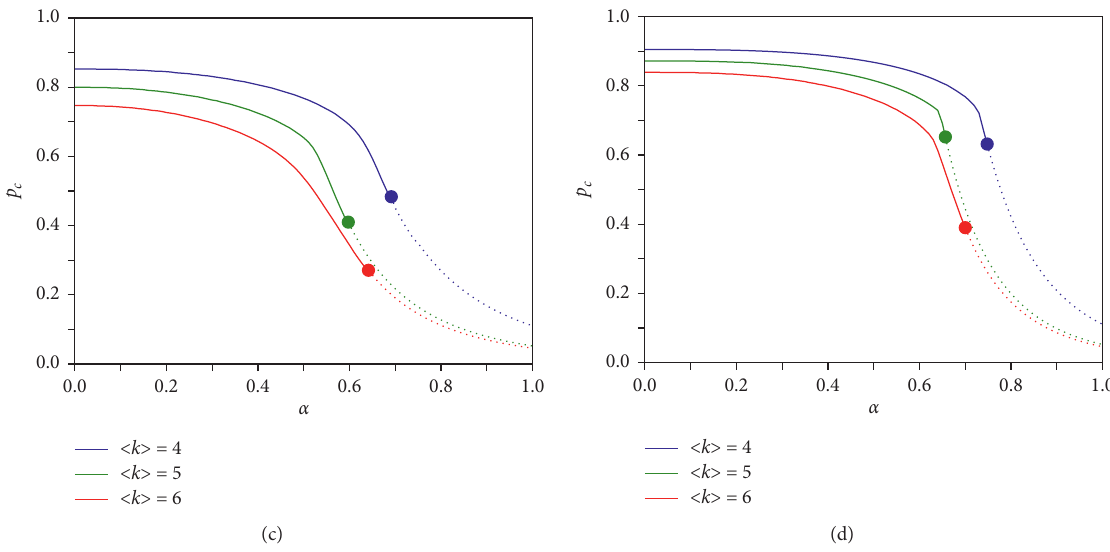
Figure 5: (Color online) (a) The percolation transition point p degree 〈 k 〉 is 4, 5, and 6 from top to bottom, respectively. (b) Corresponding results for four-layer random networks. (c) The corresponding results for three-layer scale-free networks of average degree 〈 k 〉 4, 5, and 6 (corresponding to a power-law exponent of degree distribution − 2 . 6, − 2 . 3, and − 2 . 1 from top to bottom, respectively) with minimum degree 2. (d) Corresponding results for four-layer scale-free networks.